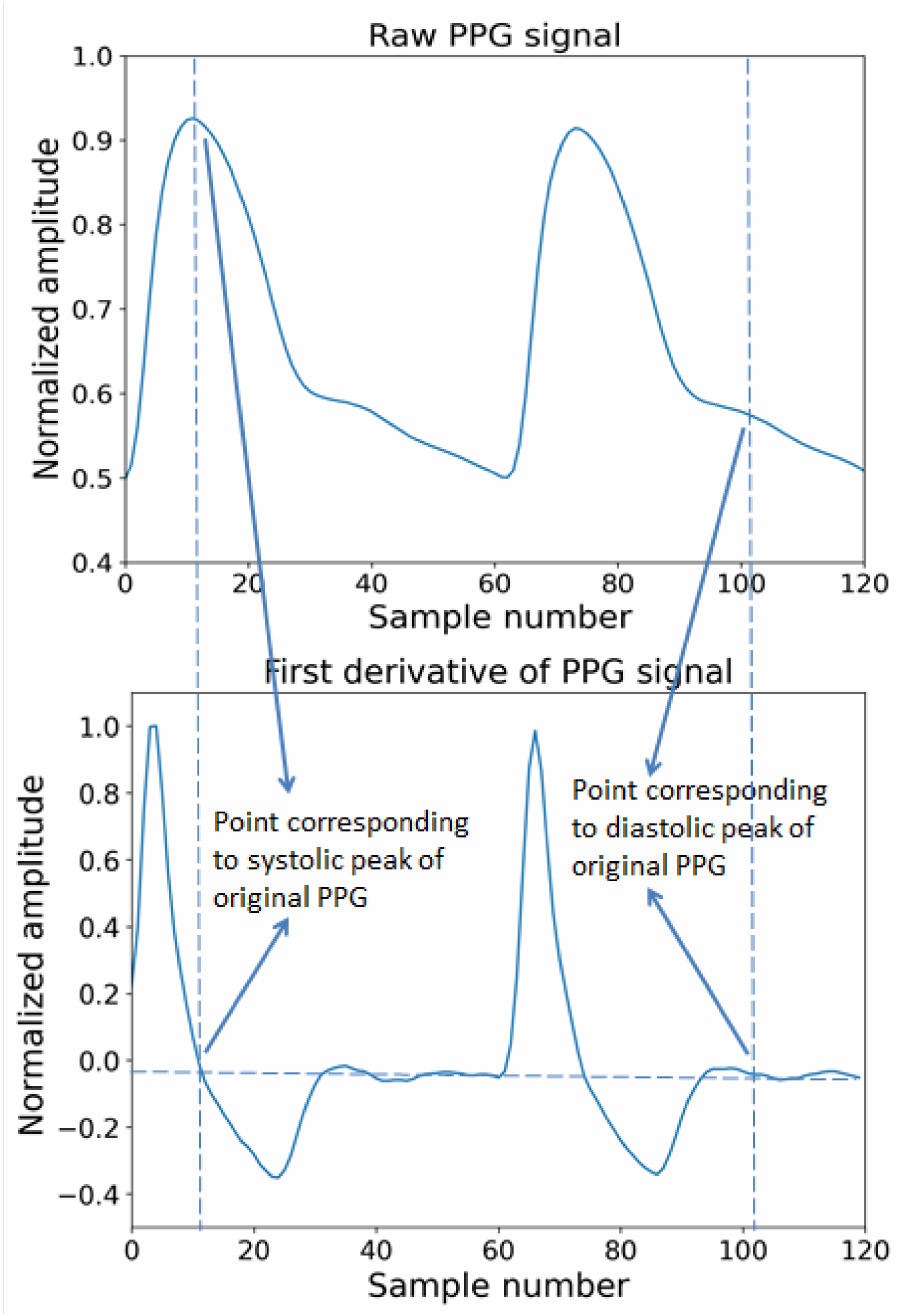
Figure 5. Original raw PPG wave and first derivative of PPG